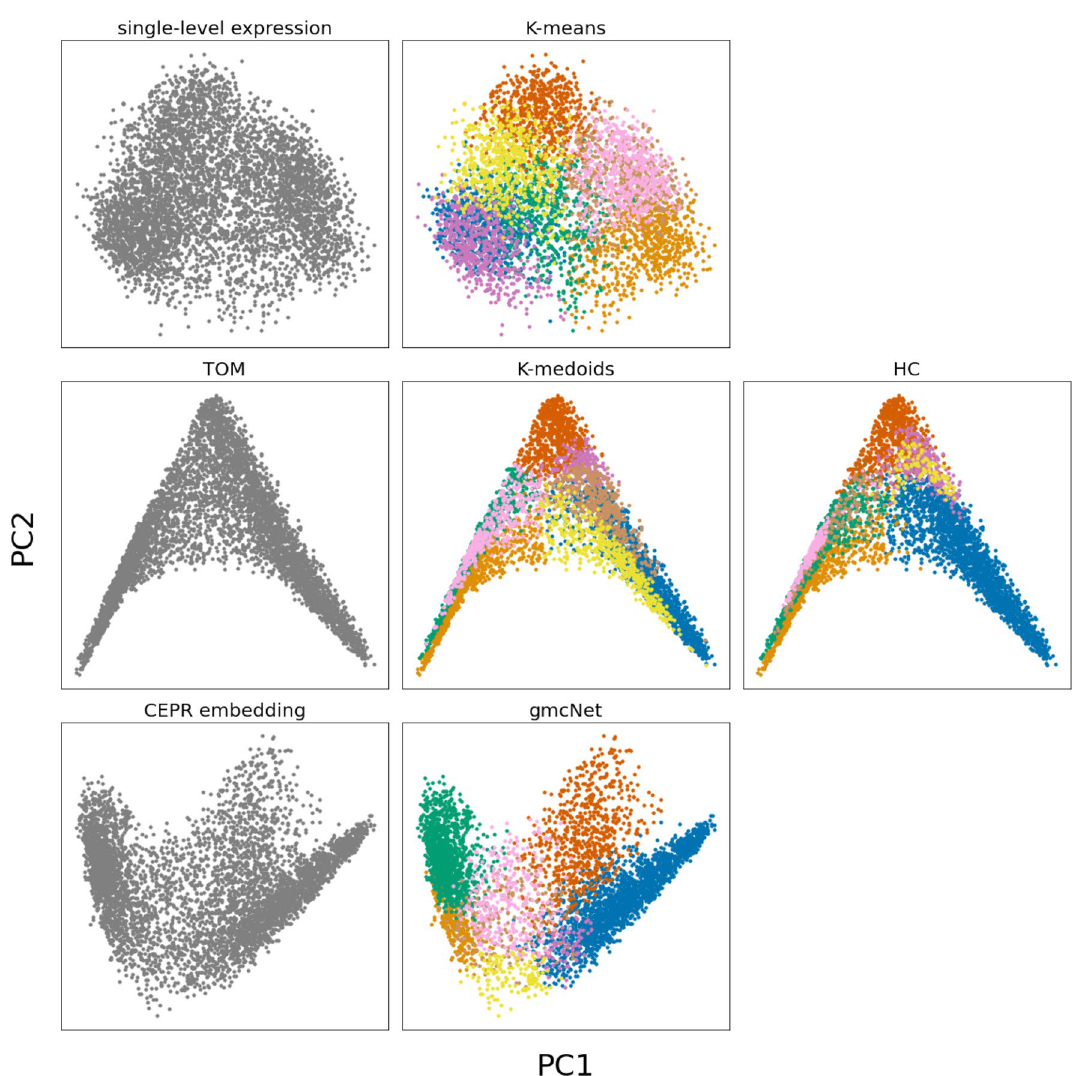
Figure 2. First and second principal components of three feature type of Korean native cattle dataset and clustering results of each method. The x-axis and y-axis are first and second principal component. The colors show the module memberships determined by the methods on the